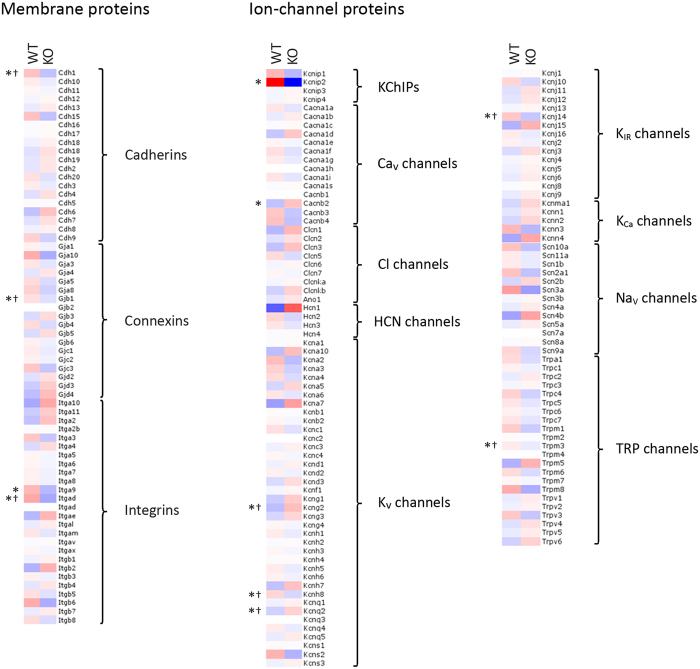
Expression of genes encoding membrane and ion-channel proteins in WT (n = 3) and KChIP2−/− (n = 3) hearts using the Affymetrix Mouse Gene 482 1.0 array.Colours indicate log2-transformed and mean normalized expression levels from high (red) to low (blue) shown in pseudo colours of the z-score (standard deviations from the mean). *P < 0.05 (Student’s t test). †Gene not expressed above the level of background noise (indicated for genes with statistically significant differences only). Integrin α-9 (Itga9) and the β2 subunit of the L-type Ca2+ channel (Cacn2b) were expressed at 82% and 135%, respectively, in KChIP2−/− hearts, relative to WT. KChIP2 was not detected in KChIP2−/− hearts.